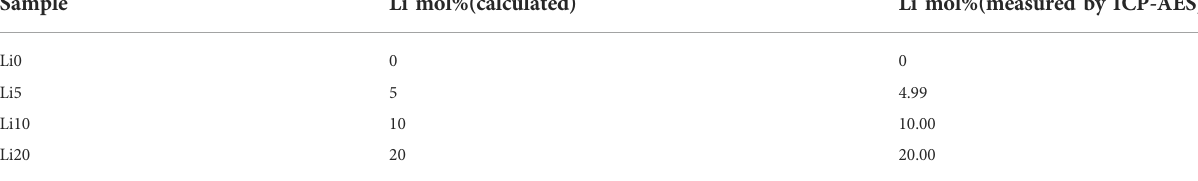
TABLE 1 Notation of different content of Li ions substituted in BCP